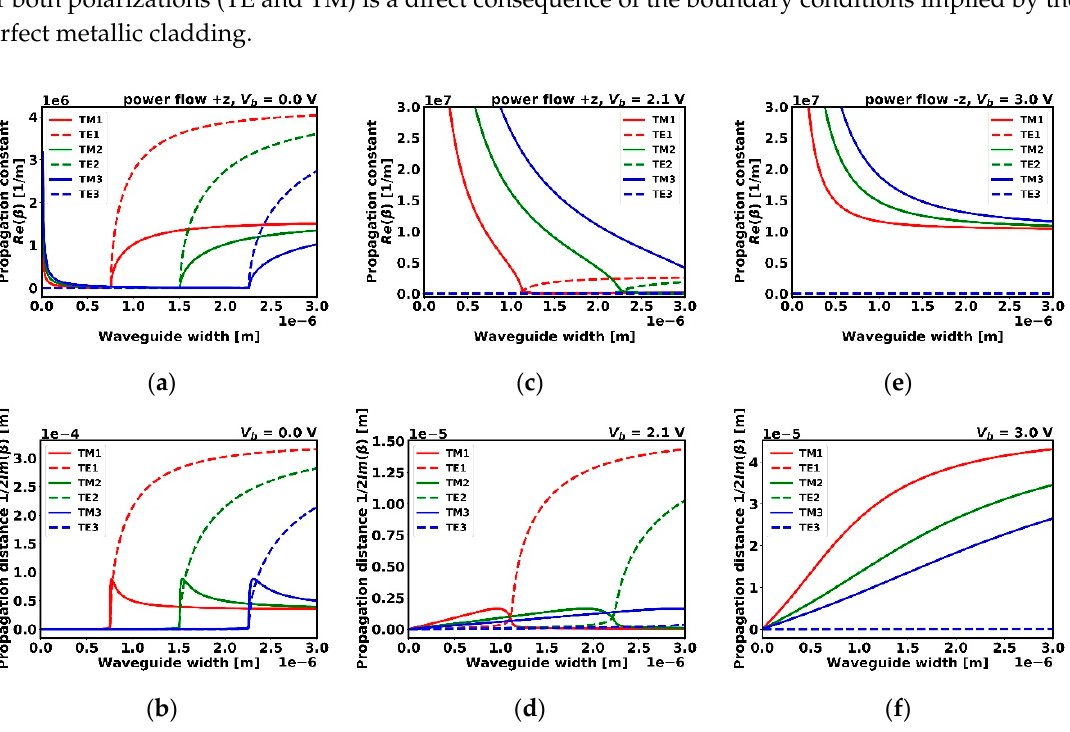
Figure 3. Propagation constant for configuration A at 1.55 µm in various dispersion regimes, dependent on the voltage bias V b applied: ( a , b ) positive elliptic (0 V), ( c , d ) Type I HMM (2.1 V), and ( e , f ) Type II HMM (3 V). Power flow direction is indicated.